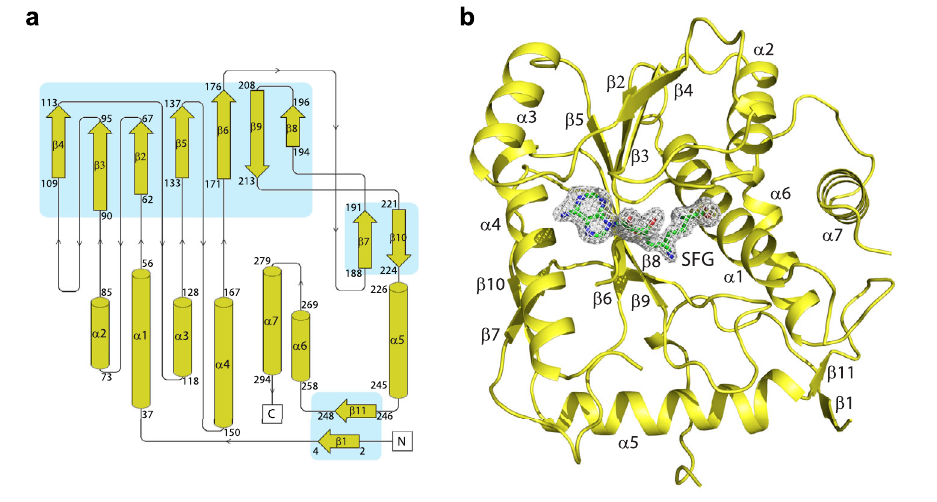
Fig. 1 | Crystal structure of the monkeypox virus VP39 methyltransferase in complexwithsinefungin. a Topologyplot of the monkeypoxvirus VP39protein. b Overall fold of the VP39 protein in complex with sinefungin. The protein back- boneisshownincartoonrepresentationanddepictedinyellow,whilesinefunginis